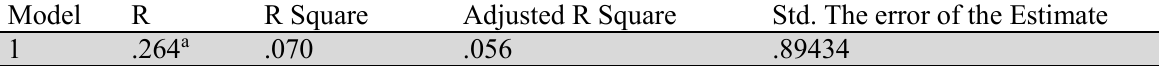
Model summary of the regression analysis